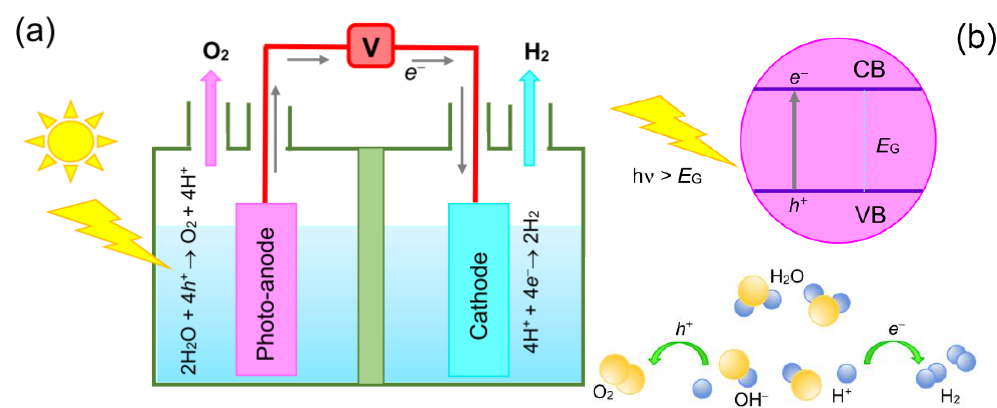
Figure 28. Schematic illustration of ( a ) a cell for photo-assisted water splitting employing an n -type semiconductor as photo-anode (inspired by references [214,215]), and ( b ) photo-generation process of electrons and holes (top), acting as the reducing and oxidizing agents (bottom), respectively.